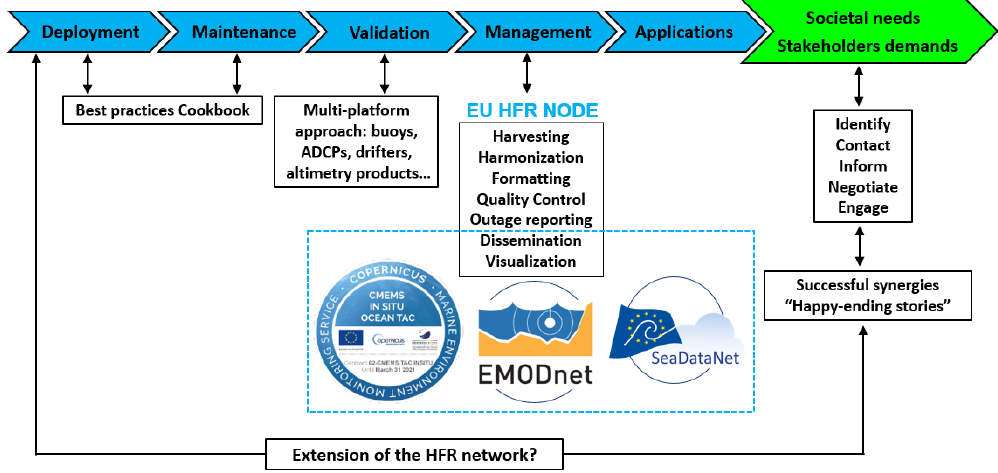
Figure 7. Basic roadmap for the homogenization and distribution of HFR data from the data providers to end